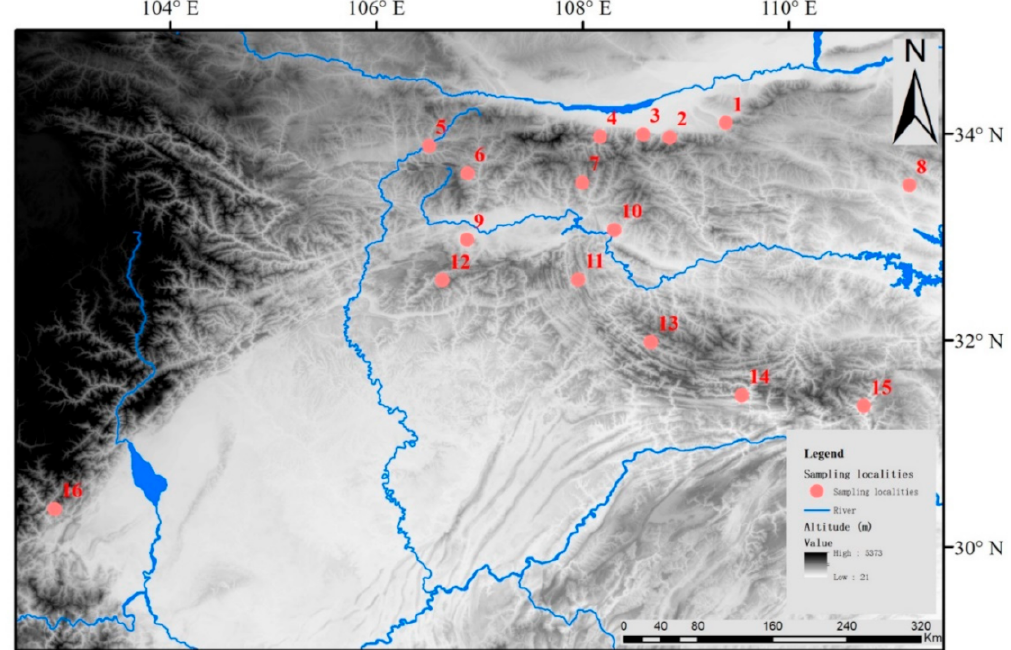
Figure 1. Sampling sites distribution of Sus scrofa population in this study. The numbers indicate local populations (see Table 1 for